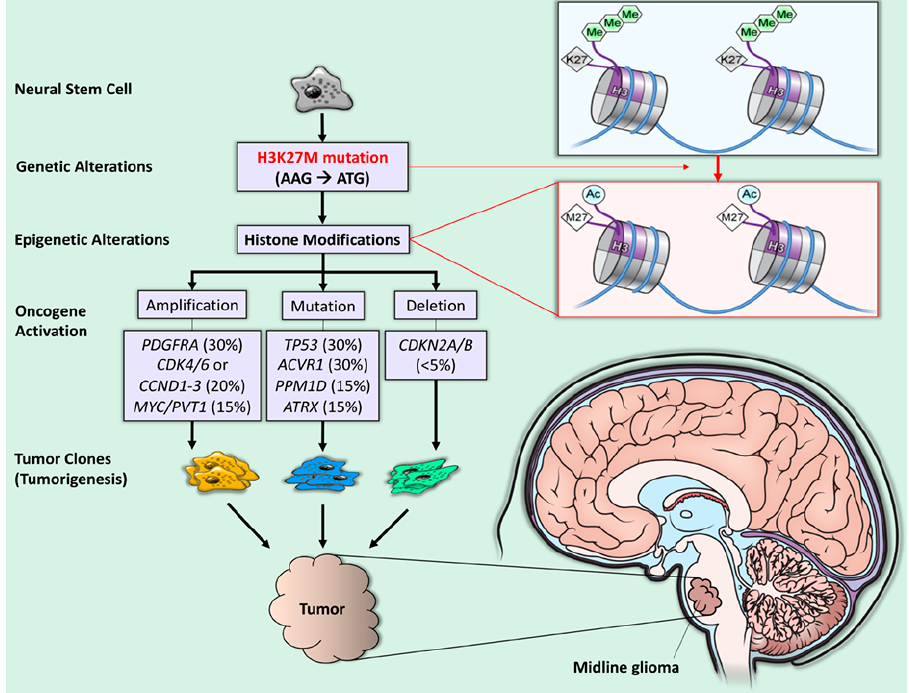
Figure 1. H3K27M mutation and tumorigenesis in diffuse midline glioma. The H3K27M mutation is a recurrent somatic gain-of-function missense mutation (AAG → ATG), resulting in a lysine 27 to methionine (p. Lys27Met: K27M) substitution in histone 3 (H3) variants (purple quadrant). The blue line represents double-stranded DNA wrapped around histones (short, segmented cylinders) regulating normal gene expression. The H3K27M mutation leads to the global loss of H3K27 trimethy- lation (green hexagons) and subsequent gain of H3K27 acetylation (blue circles), which is linked to oncogenesis (gene amplification, mutation, and deletion) and, subsequently, tumorigenesis [1].